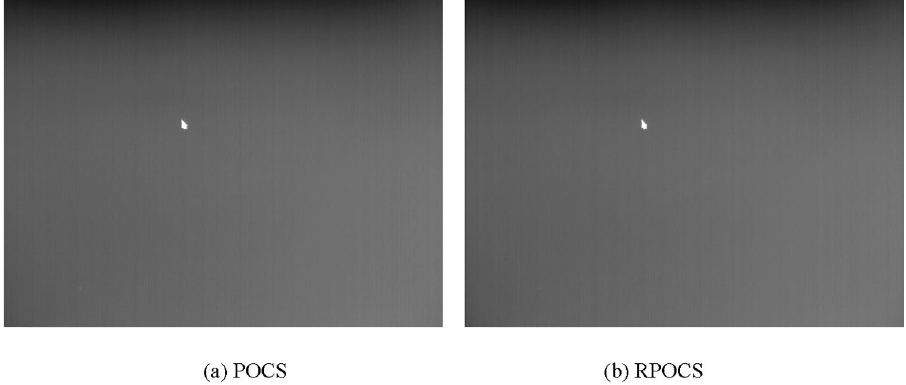
Figure 5. Effect of two restoration algorithms for plane image in sky background.